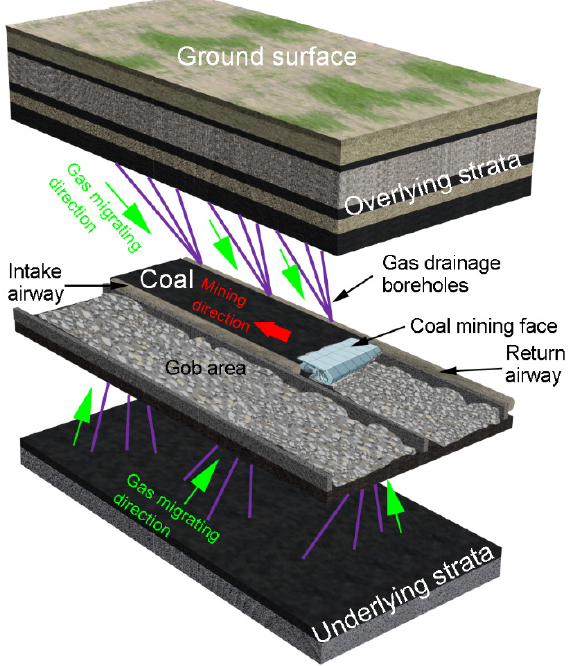
Figure 8. Three ‐ dimensional diagram for integrated coal and gas production. Figure 8. Three-dimensional diagram for integrated coal and gas